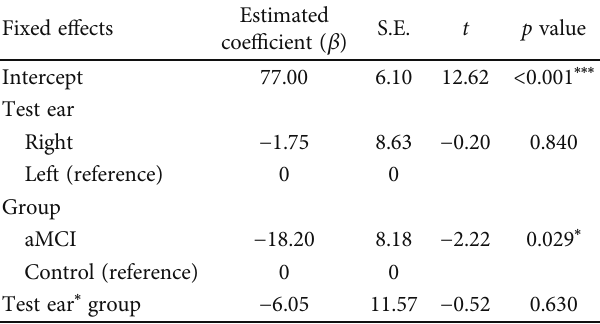
Table 5: Estimated fi xed e ff ects of predictors for approximate threshold of gap